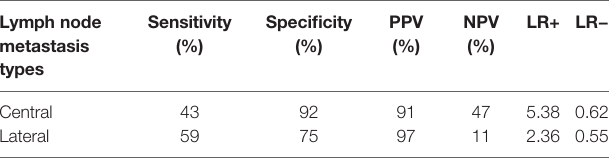
TABLE 3 | Ability of Delphian node metastasis to predict central and lateral lymph node metastasis. Lymph node metastasis